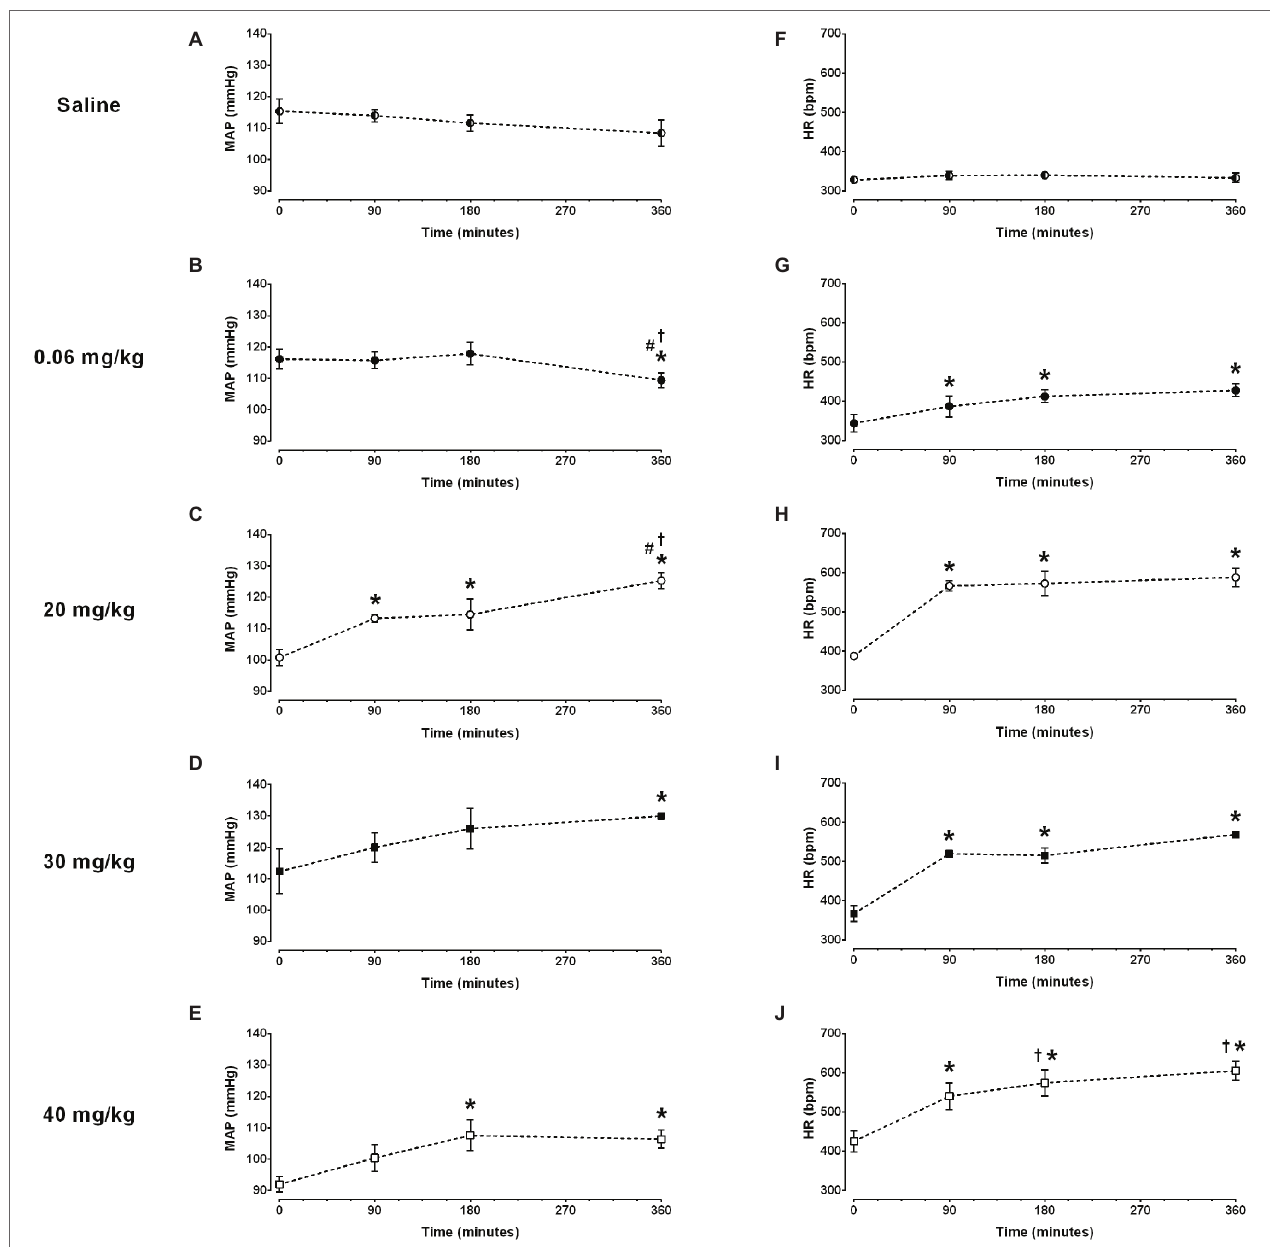
FIGURE 1 | Time course of mean arterial pressure (MAP) and heart rate (HR) response to different doses of lipopolysaccharide in unanesthetized rats. Saline: panels (A,F) ; 0.06 mg/kg of LPS: panels (B,G) ; 20 mg/kg of LPS: panels (C,H) ; 30 mg/kg of LPS: panels (D,I) ; 40 mg/kg of LPS: panels (E,J) . Data are expressed as mean ± standard error of the mean. * p < 0.05 vs. baseline counterpart; † p < 0.05 vs. 90 min counterpart; # p < 0.05 vs. 180 min